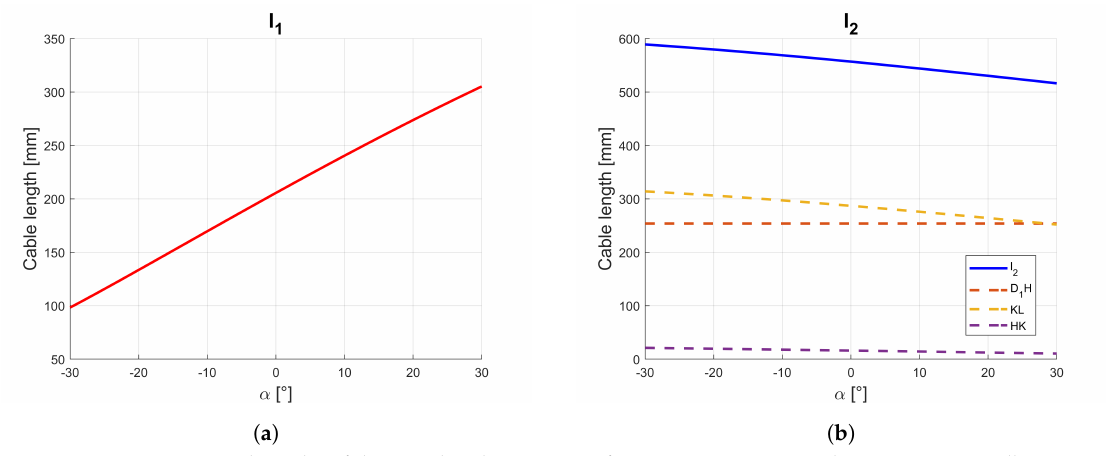
Figure 7. Computed results of the simulated operation of CADEL.3 in Figure 6 during extension elbow motion: ( a ) for l 1 cable; ( b ) for l 2 cable and its